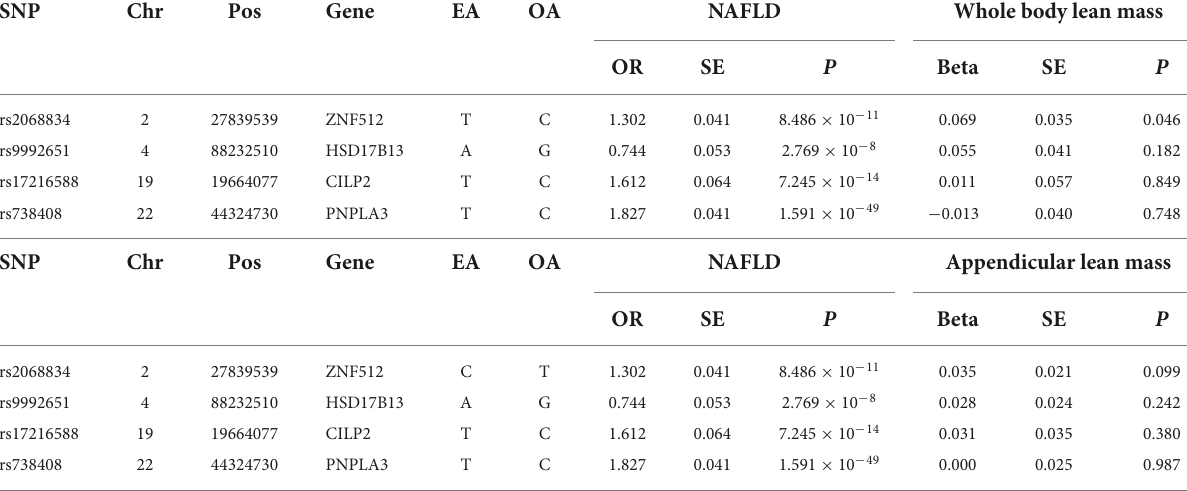
TABLE 3 Genetic instruments for NAFLD and their associations with lean body mass.